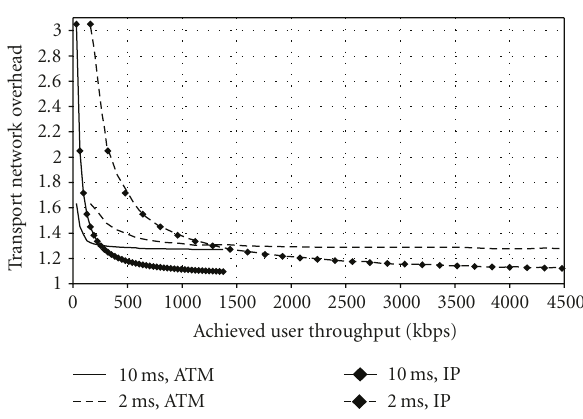
Figure 3: Transport network overhead as the function of the achieved user